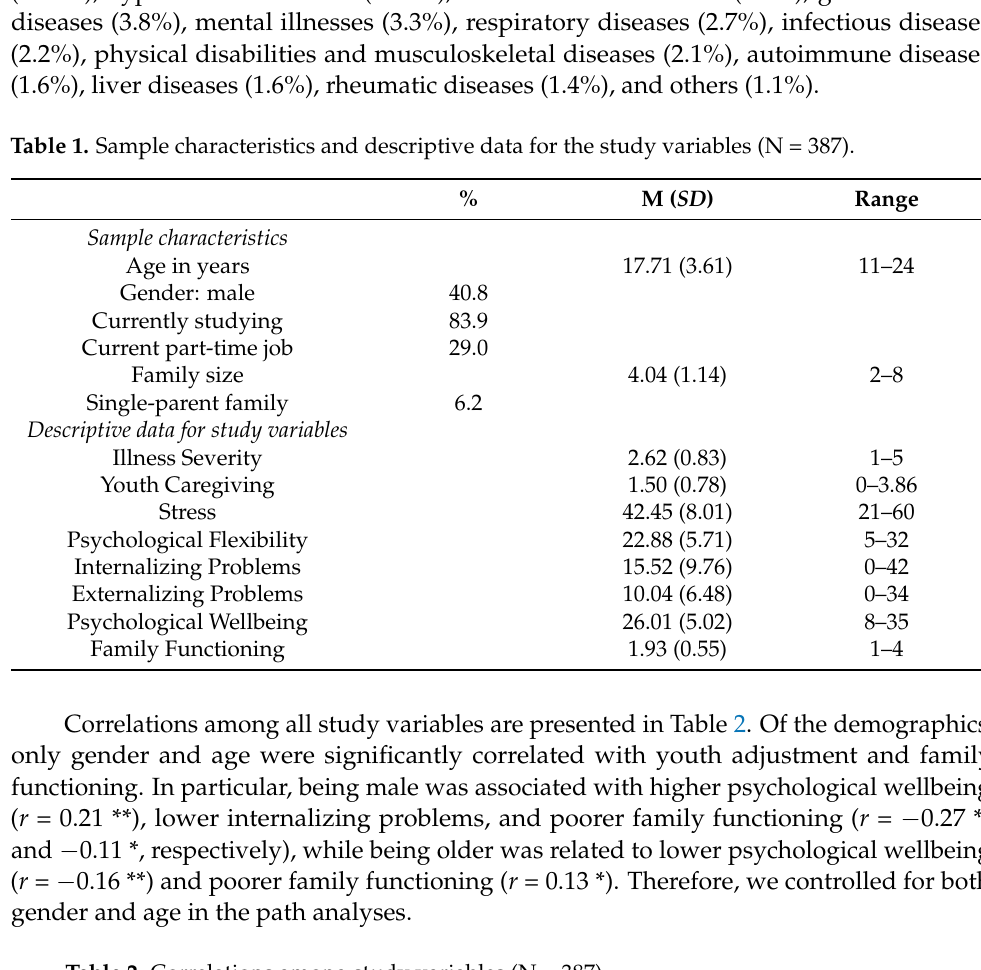
Table 2. Correlations among study variables (N =